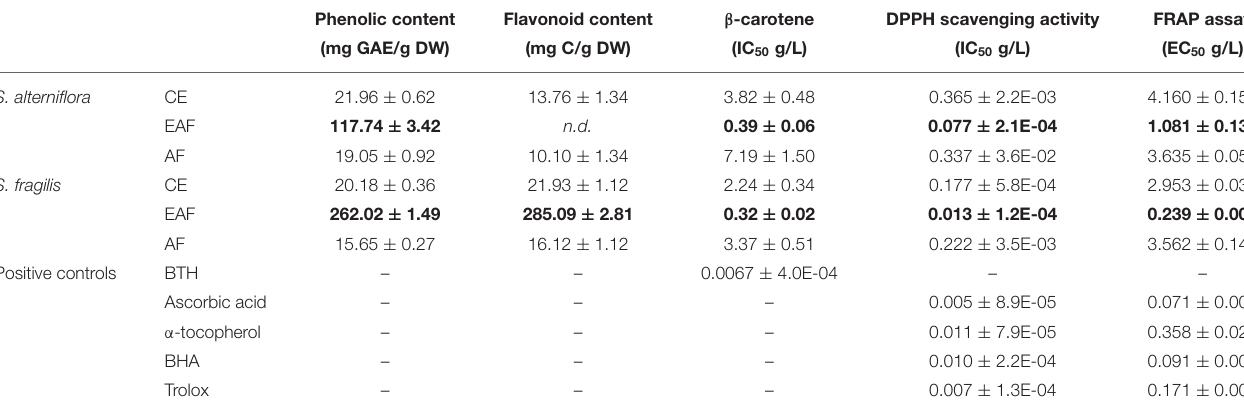
TABLE 1 | Phenolic and flavonoid contents and antioxidant activities in extracts of Spartina alterniflora and Salicornia fragilis